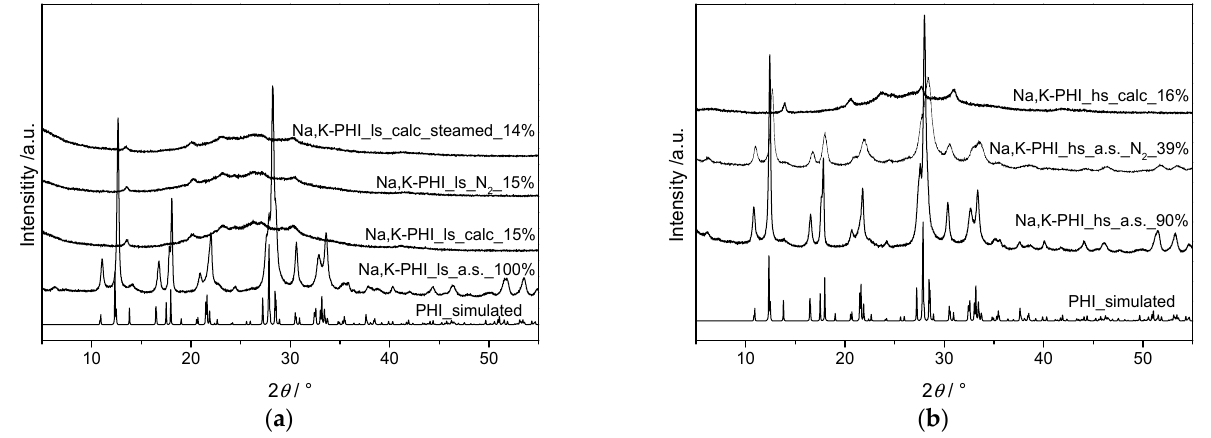
Figure 2. Powder X-ray diffractograms of the catalysts. ( a ) ls-material; ( b ) hs-material. The simulated PHI pattern confirms that crystalline PHI zeolites were synthesized. The various treatments cause the crystallinity to decrease.